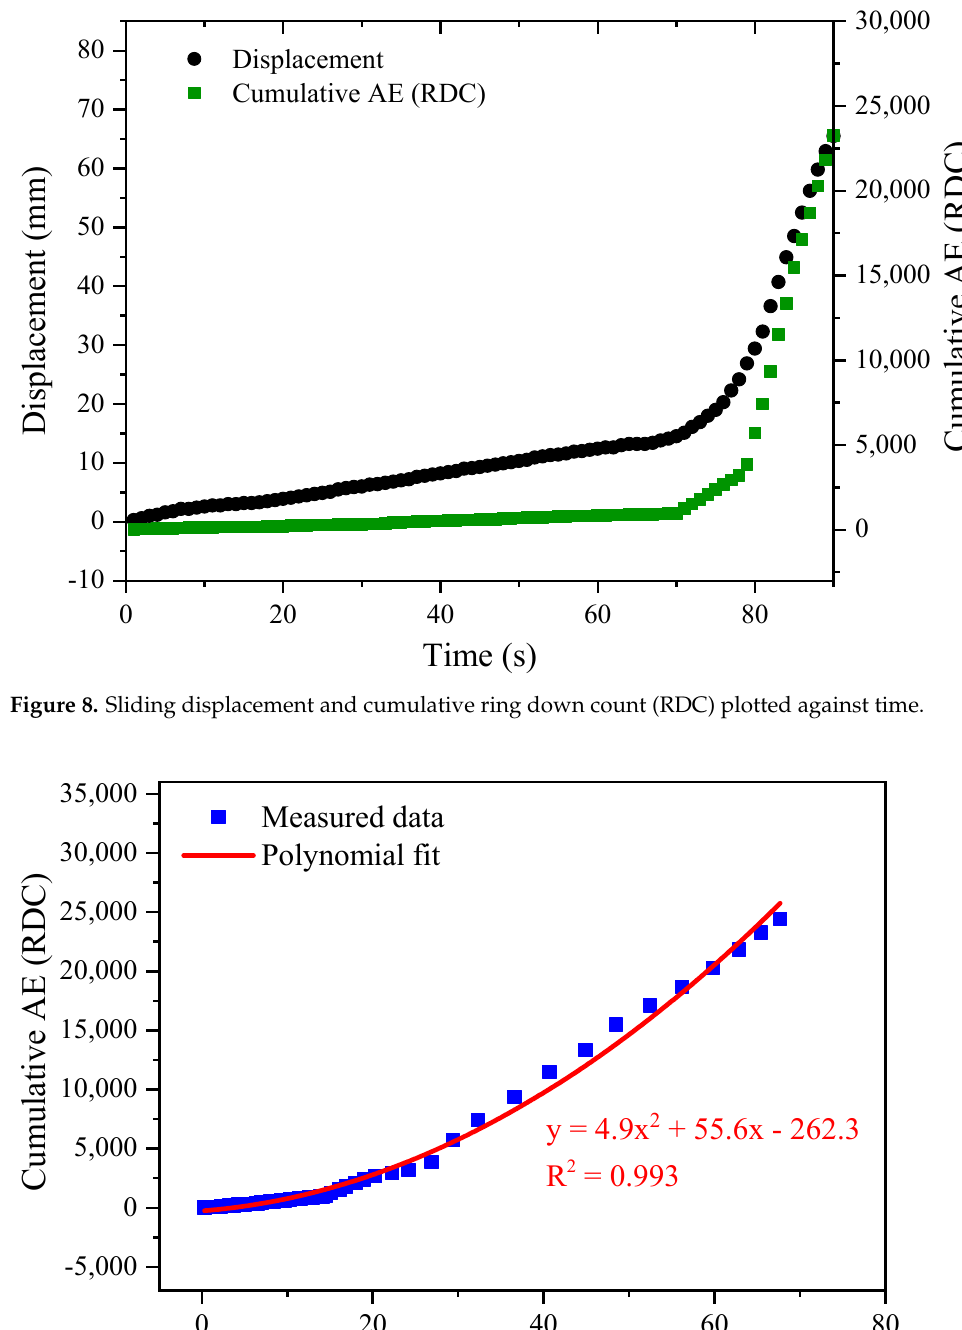
Figure 9. Polynomial fitting of sliding displacement and cumulative RDC.